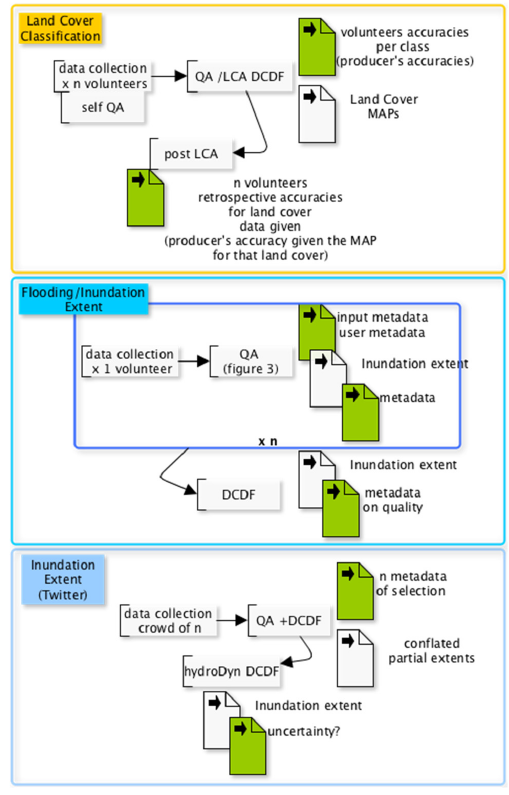
Figure 2. Data life cycle for the land cover classification ( top ) and two inundation extent examples ( middle and bottom ).